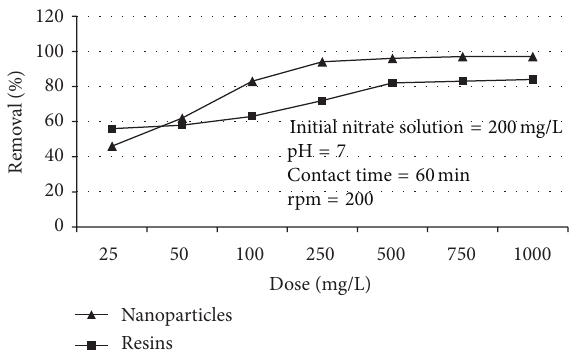
Figure 2: Effect of dose on nitrate removal by resins and Fe/Pt bimetallic nanoparticles.